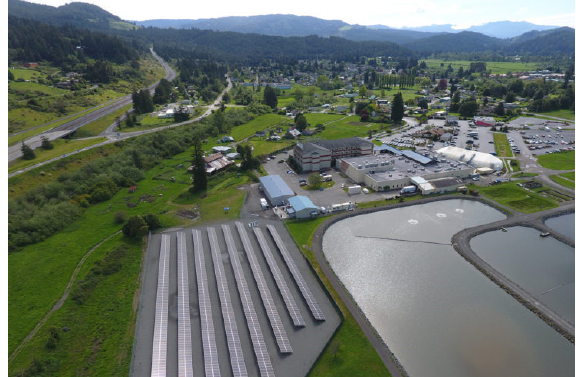
Fig. 4 Overview of the BLR community microgrid (Source: Schatz Energy Research Center, Humboldt State University) [31] .